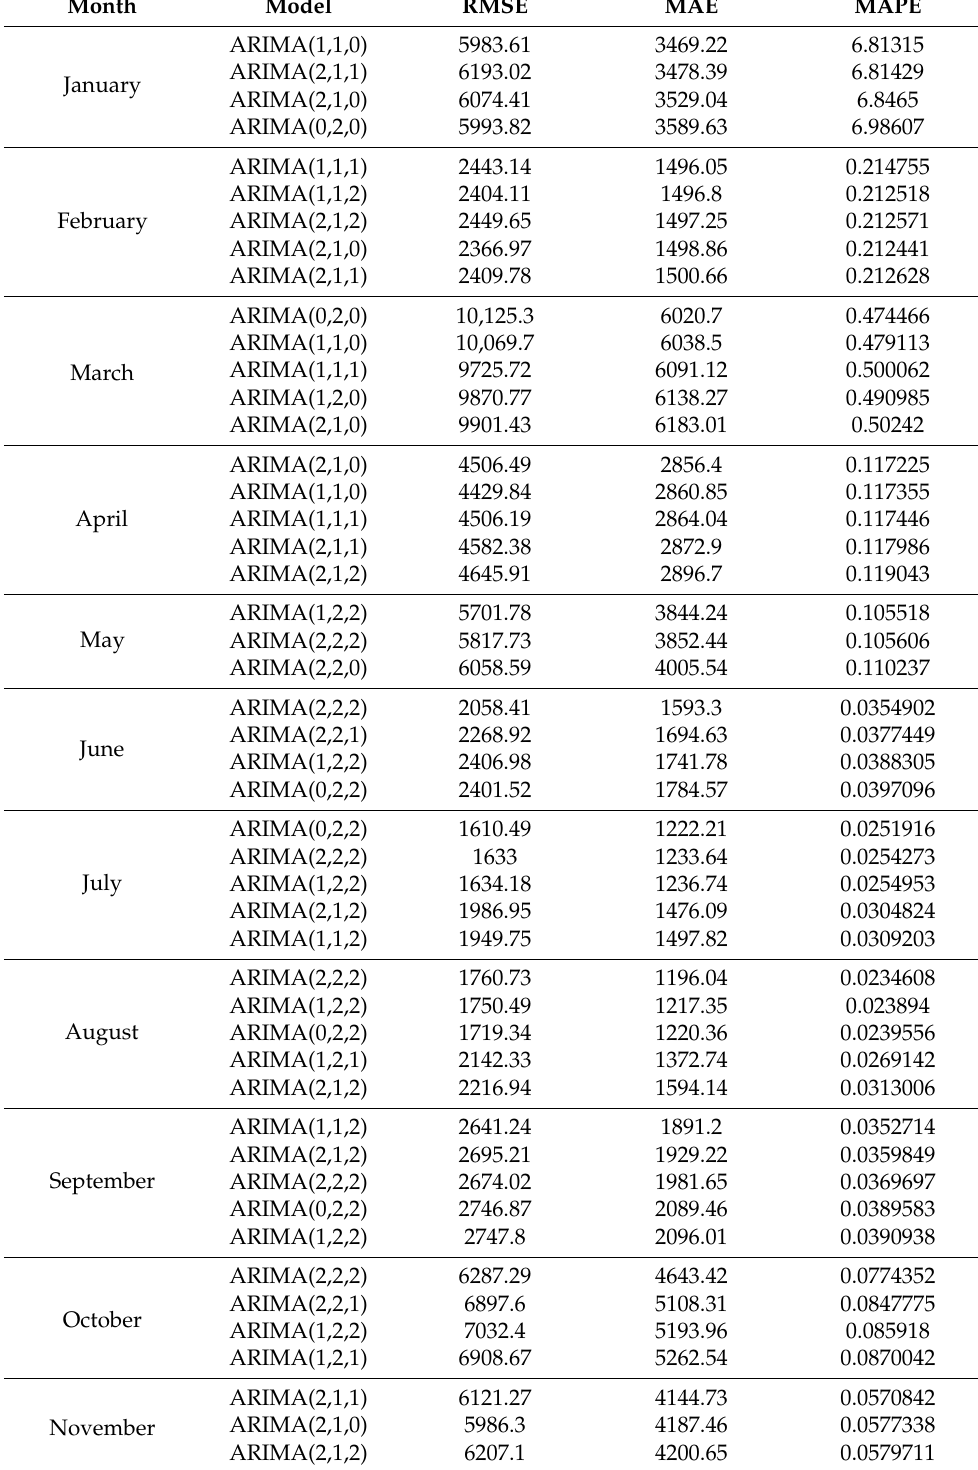
Table 1. ARIMA models